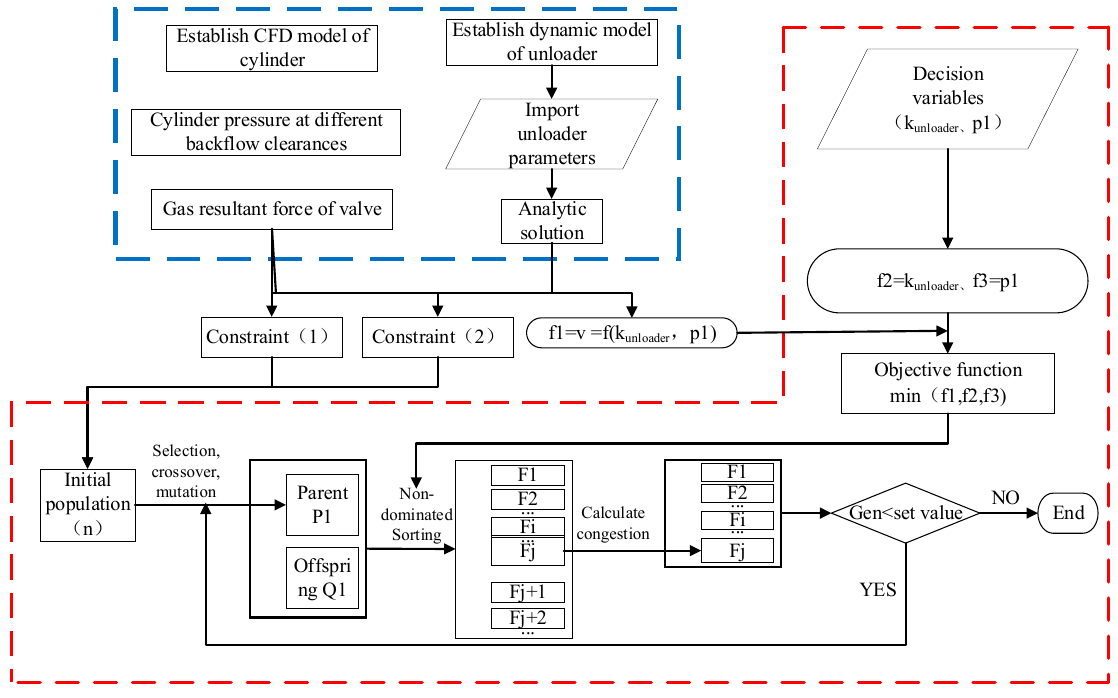
Figure 10. Optimization algorithm diagram.